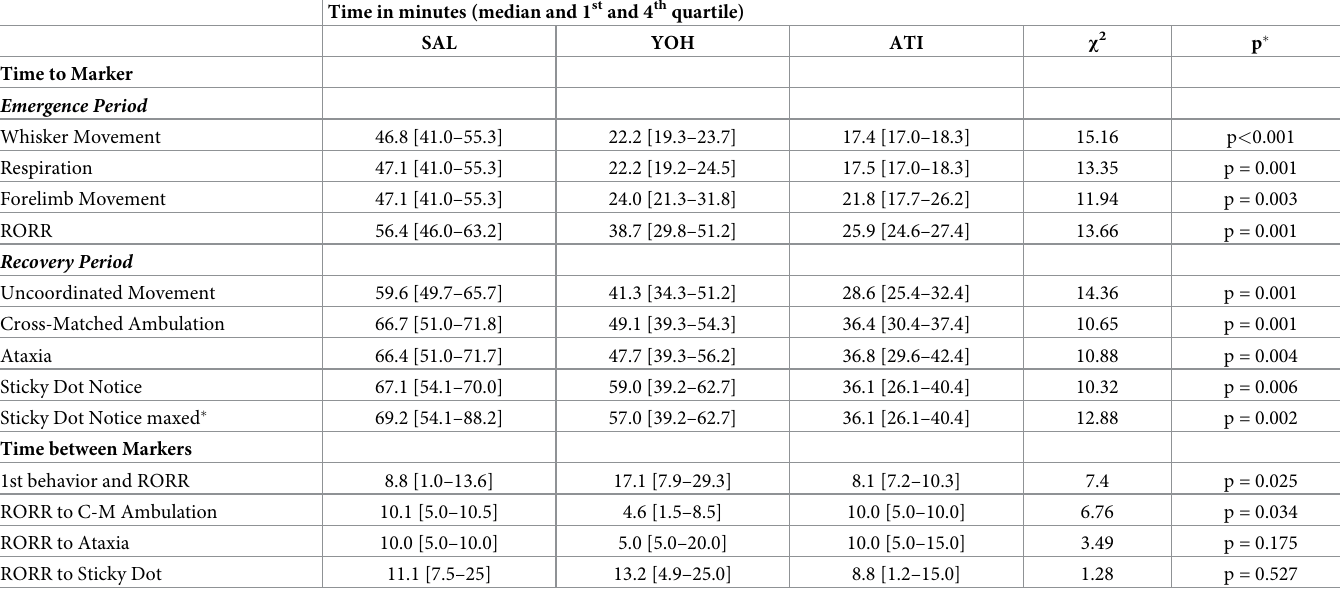
Table 1. Durations from ketamine/xylazine injection until the behavioral marker as well as between defined markers. Time in minutes (median and 1 st and 4 th